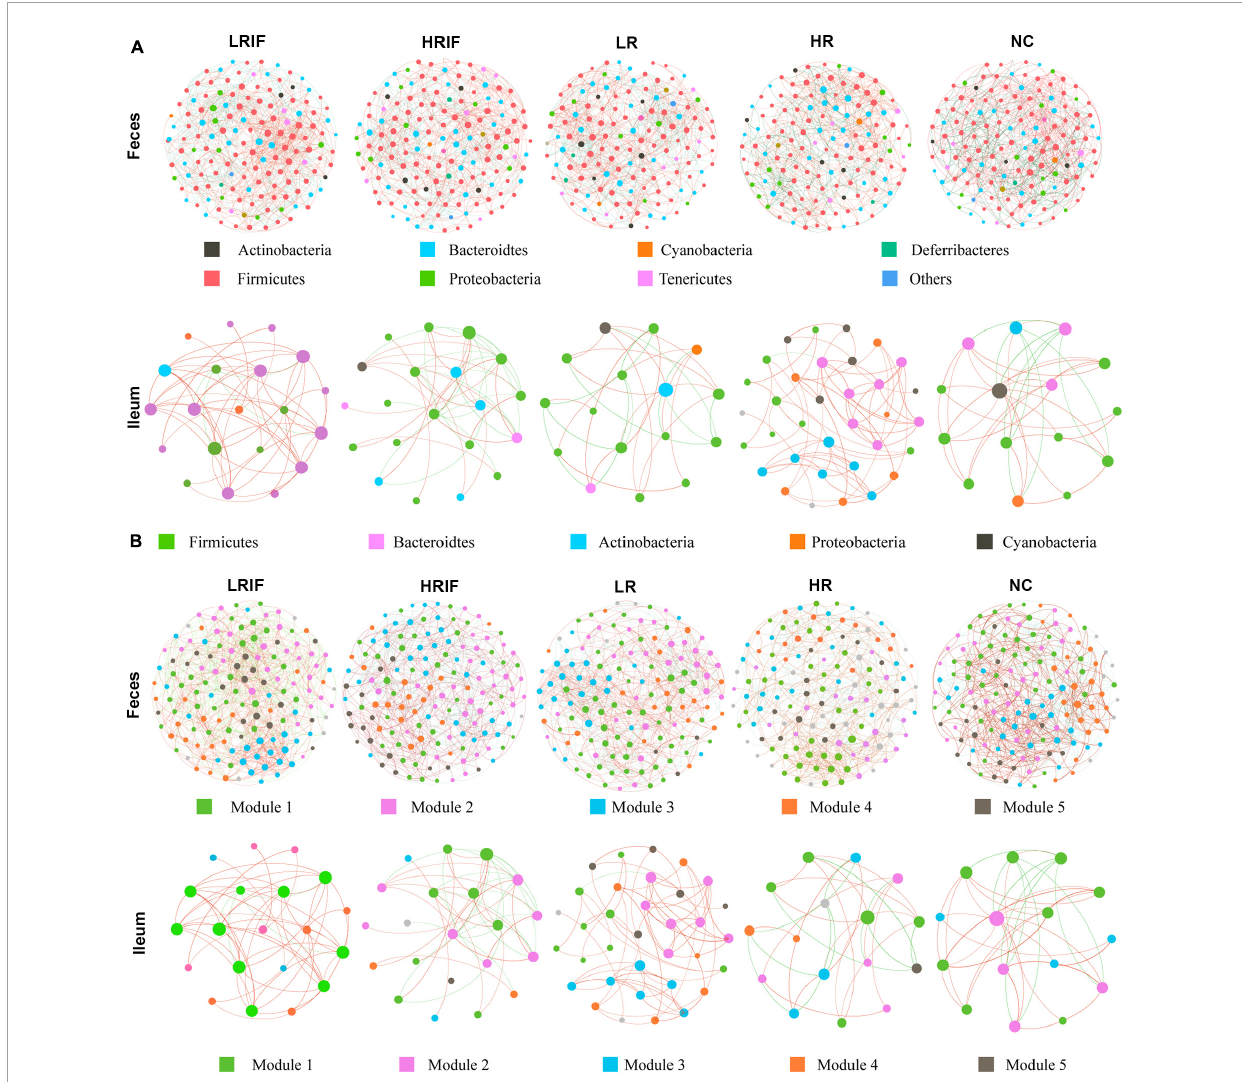
FIGURE4 Co-occurrence network analyses of microbial communities in species and modular samples. (A) The OTUs in feces were grouped by color into seven phyla including Actinobacteria, Bacteroidetes, Cyanobacteria, Deferribacteres, Firmicutes, Proteobacteria, and Tenericutes ; while OTUs in ileum were grouped by color into five phyla including Firmicutes, Bacteroidetes, Actinobacteria, Proteobacteria, and Cyanobacteria . (B) The OTUs in both feces and ileum were grouped into five major modules. Lines connecting two nodes represent a group of strong ( R > 0.6) and significant correlations ( p < 0.05). The red/orange and green/blue lines indicate positive and negative connections between the nodes. The size of each circle represents the relative abundance of each